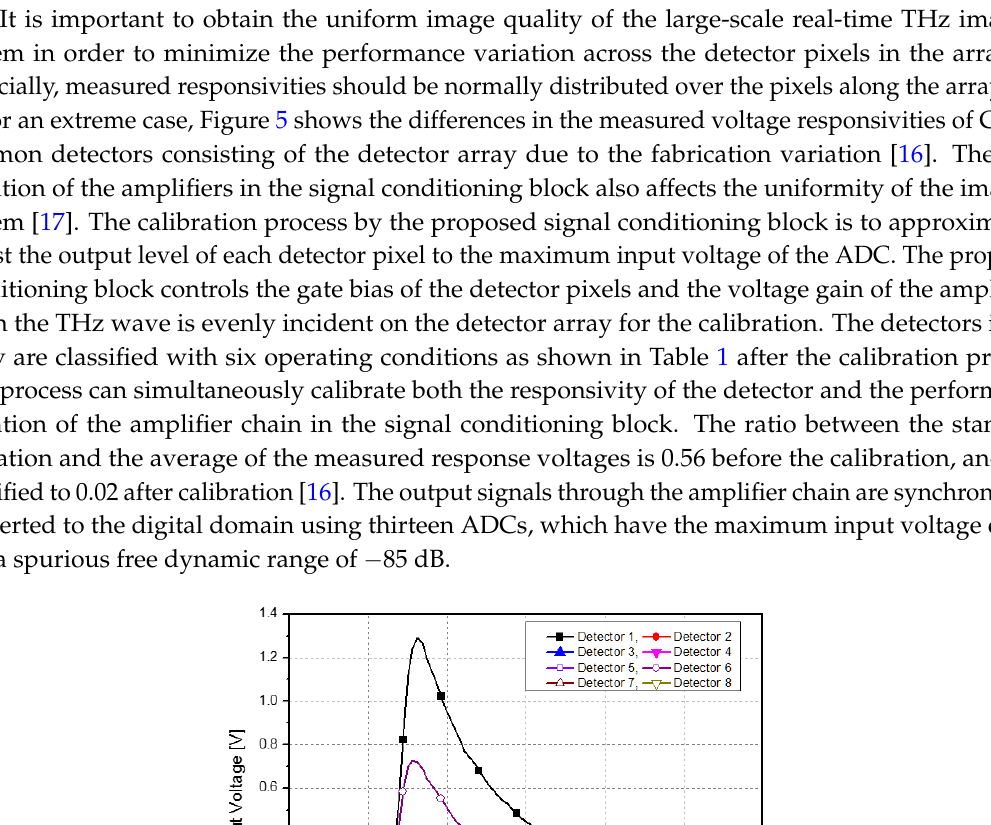
Figure 5. Eight examples of measured response voltages at the output among detector pixels in the array.